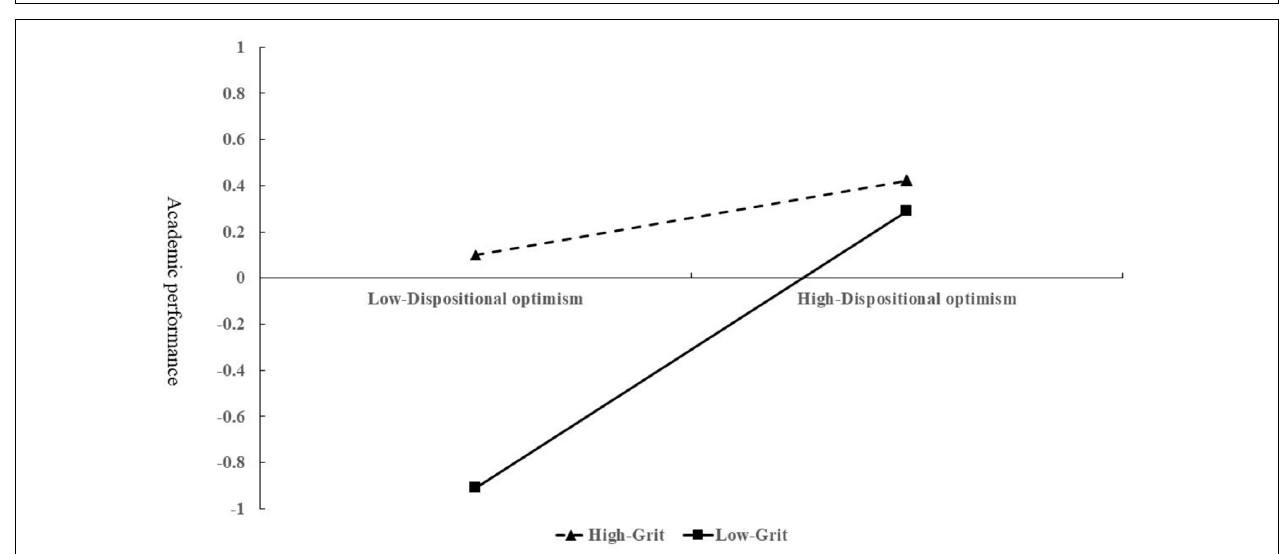
FIGURE 3 | Moderating effect of grit on the relationship between social support and dispositional.